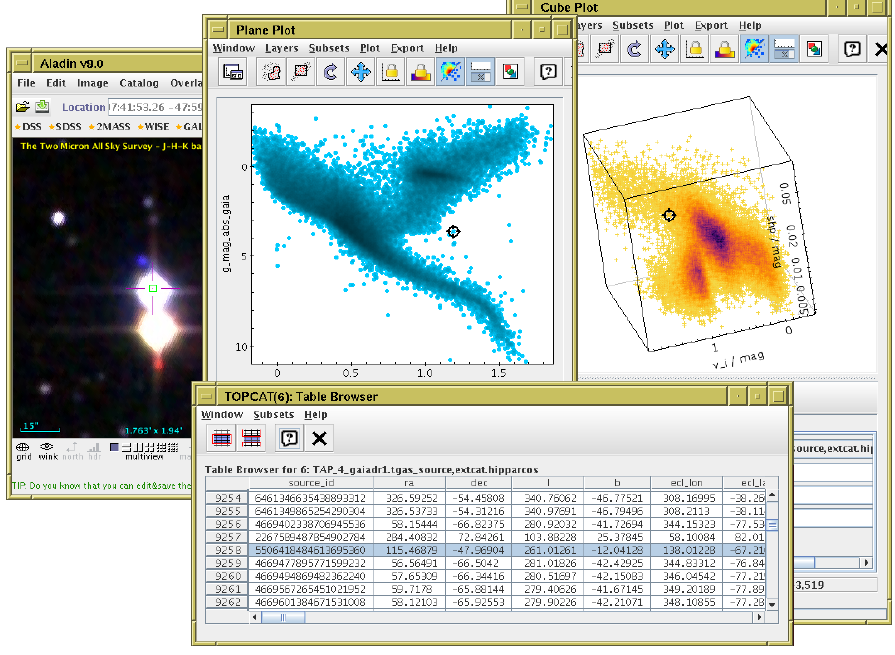
Figure 3. Linked highlighting of table rows. A user has clicked on an outlier in the 2-d plot ( center ), highlighting it with a “target” cursor. This automatically causes the same row to be highlighted in other ways: the target cursor marks the relevant point on the 3-d plot ( right ) and the row is flagged in the table data browser ( bottom ). In this case TOPCAT has also been configured to communicate with the external image display application Aladin [18] ( left ), which is caused to display a sky image corresponding to the highlighted row. This interaction makes it easy to see here that the relevant star is very close to another one; it is likely that this contamination of sources has led to a spurious brightness value, resulting in its anomalous position in the 2-d plot. Data show a Gaia-Hipparcos colour magnitude diagram and 2MASS colour